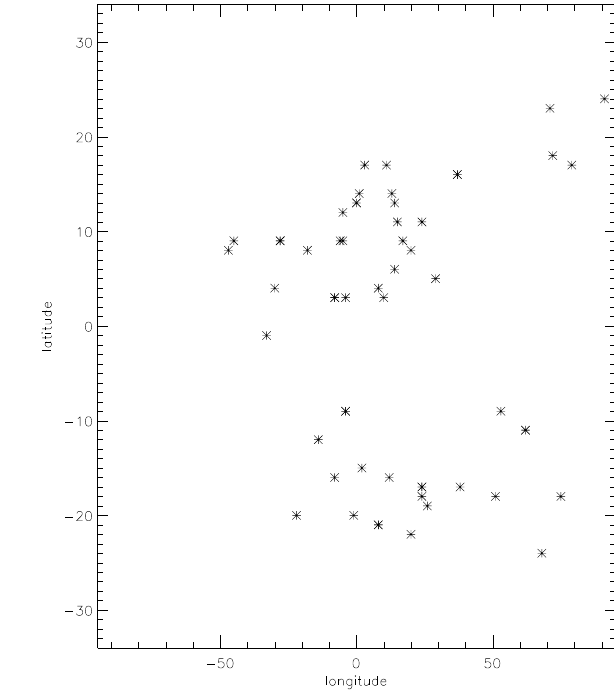
Fig. 3. Latitude versus longitude distribution of CMEs sources.